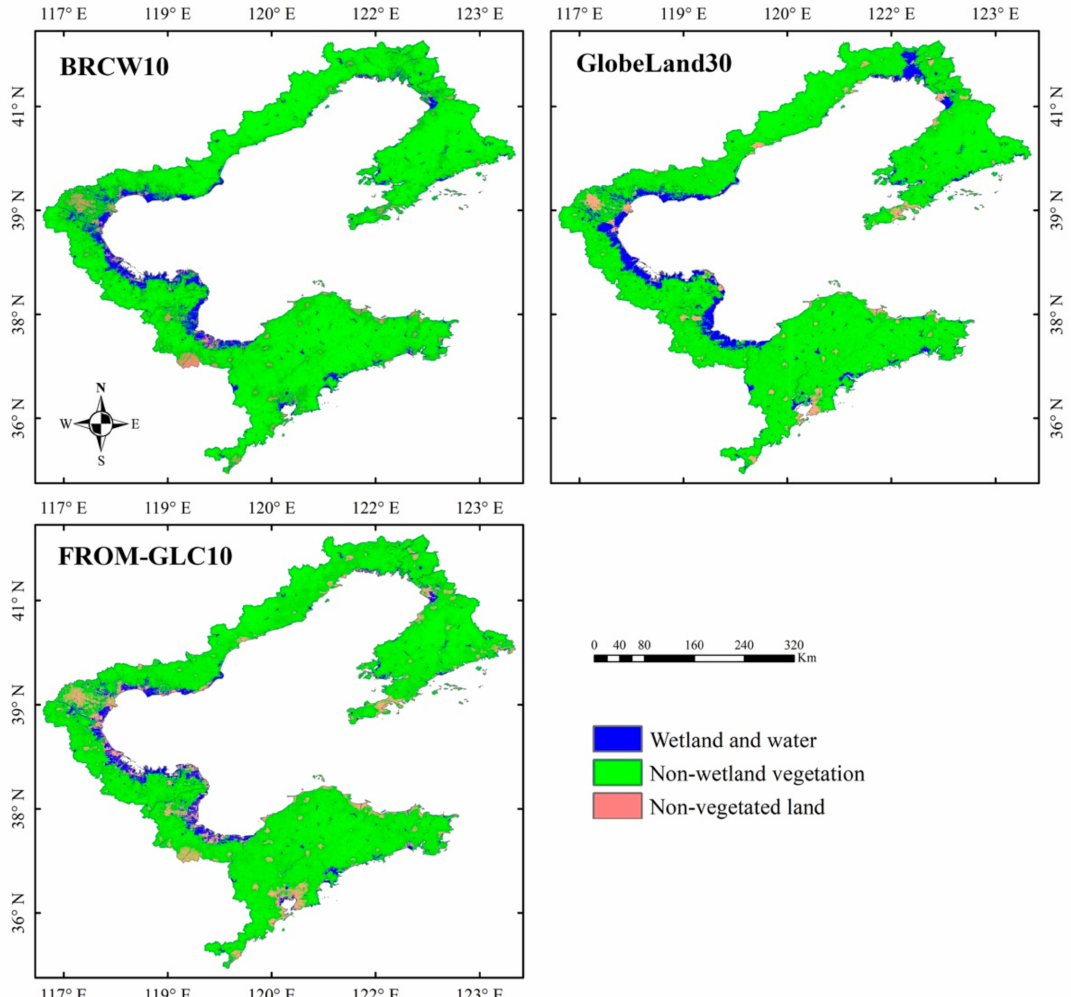
Figure 6. Comparisons among BRCW10, GlobeLand30, and FROM-GLC10 wetland